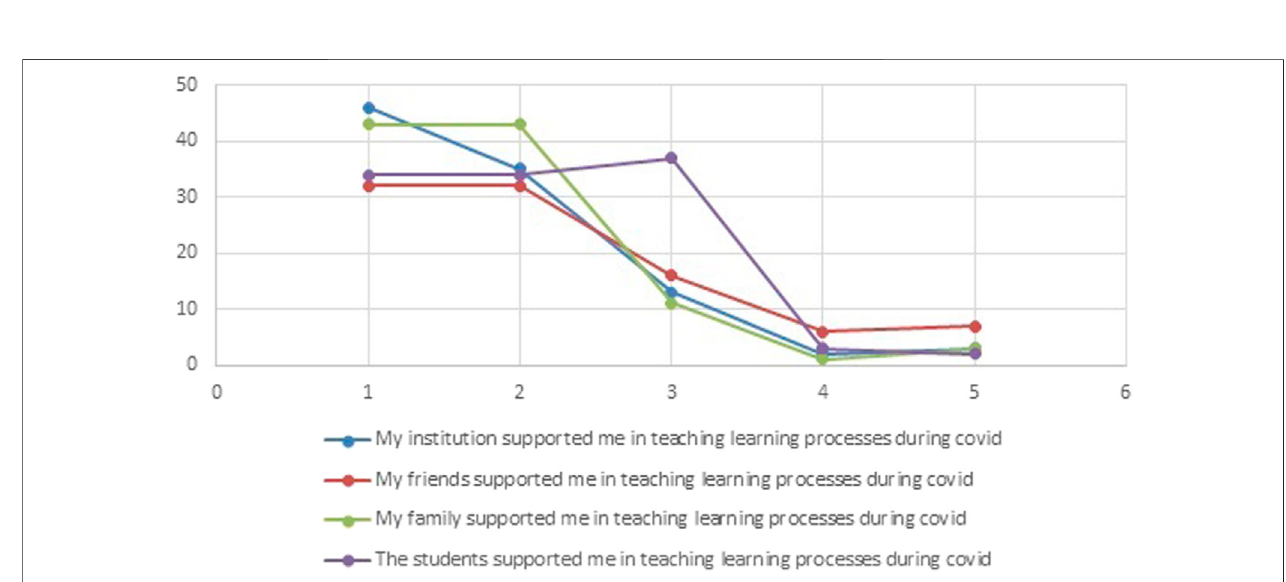
FIGURE 2 | Factors related to external resilience. Note. 1 (cid:1) Strongly Agree and fi ve Strongly Disagree.